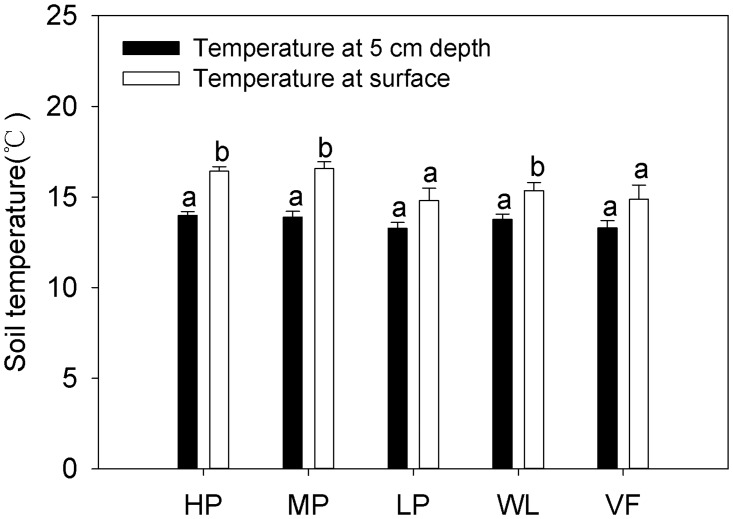
Annual mean soil temperature measured at the surface and 5 cm depth at five adjacent experimental sites.HP = tea garden with high production, MP = tea garden with medium production, LP = tea garden with low production, WL = woodland, VF = vegetable field. Vertical bars indicate standard error. Bars labelled with the different lowercase letters at the same site denote significant difference at p<0.05.